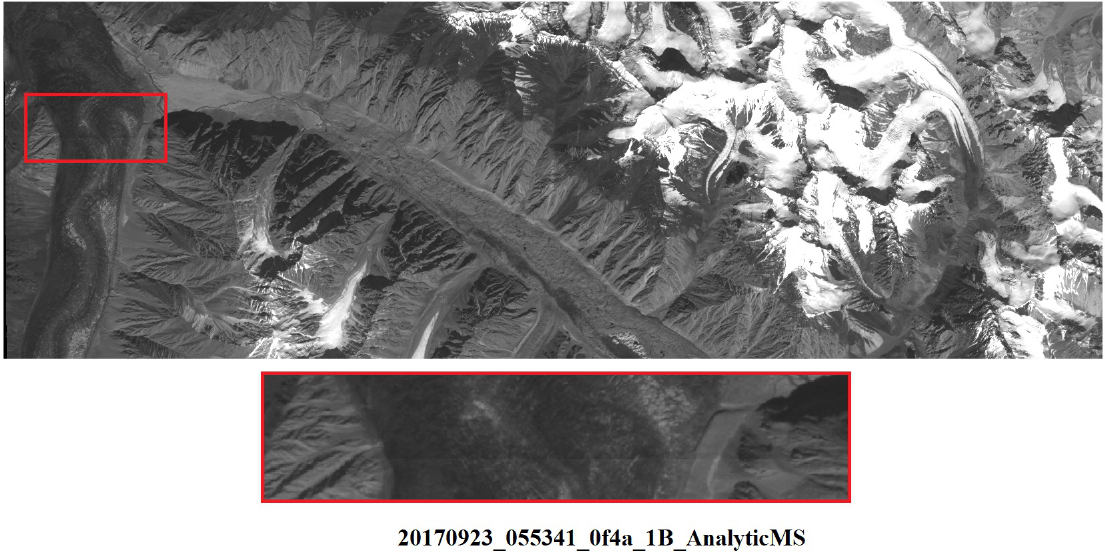
Figure 20. Artefact in the NIR band of an image from Khurdopin Glacier. The zoomed area is shown in the red